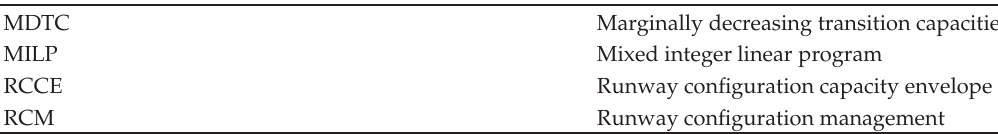
Table 1: Frequently used